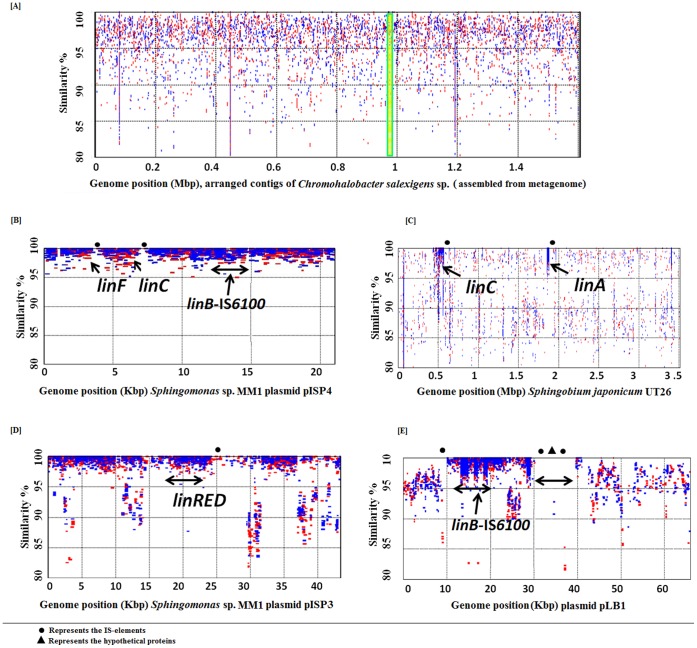
Quantifying the enrichment of environmental genomes/plasmids.Metagenomic recruitment plots of genomes/plasmids constructed using all three studied metagenome sequences. Reads were mapped with coverage parameter. (A) Assembled contigs of Chromohalobacter salexigens (5189 contigs) from mtegenomic reads, shaded region represents the location of 16SrRNA gene sequence. (B) pISP4, (C) Sphingobium japonicum UT26 chromosome 1, (D) pISP3 and (E) pLB1. Localization of lin genes on respective genomes is marked along with representation symbols for IS-elements.